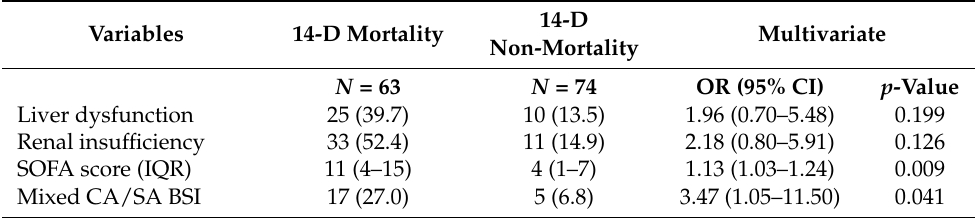
Table 3. Multivariate analysis of high variance factors that are associated with 14-day mortality for patients with